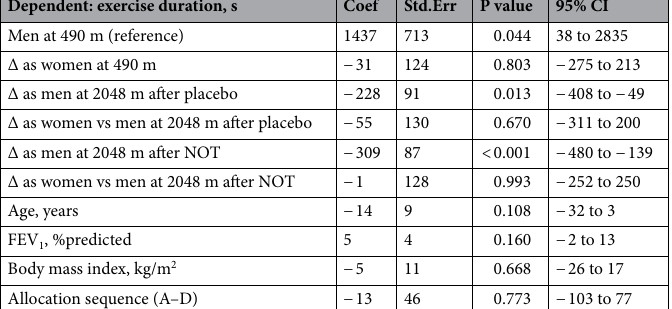
Table 3. Multivariable regression model to assess predictors at 490 m of the exercise endurance time at 2048 m. Intention-to-treat population (N = 32). FEV 1 forced expiratory volume in the first second of